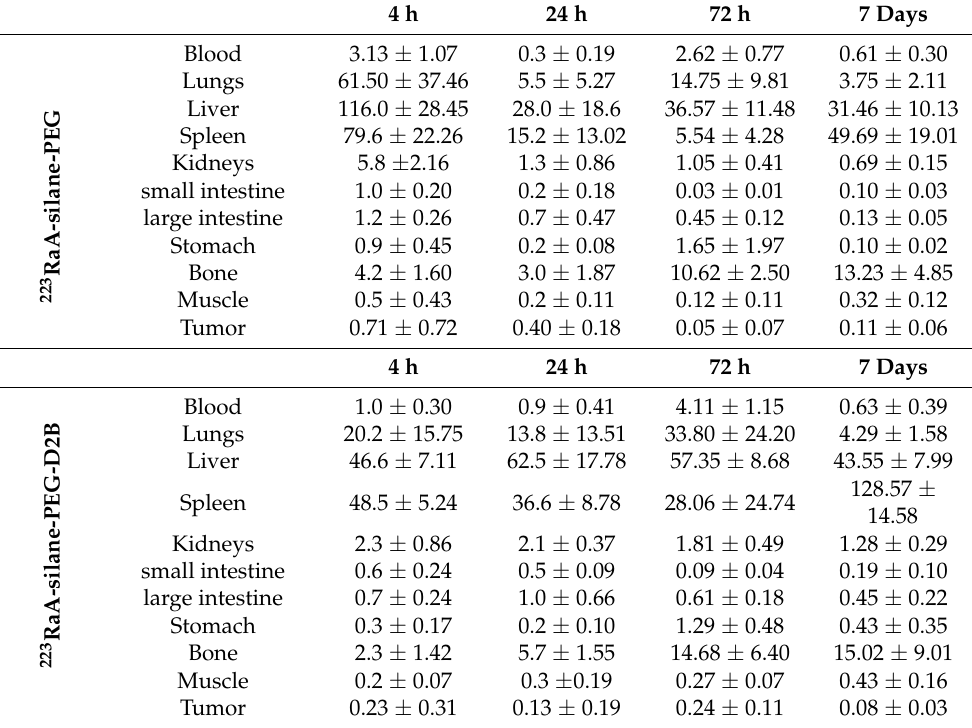
Table 3. Biodistribution of 223 RaA-silane-PEG and 223 RaA-silane-PEG-D2B in BALB/c Nude mice at 4, 24, 72 h and 7 days post injection. Values are expressed as %ID g − 1 and presented as mean ± standard